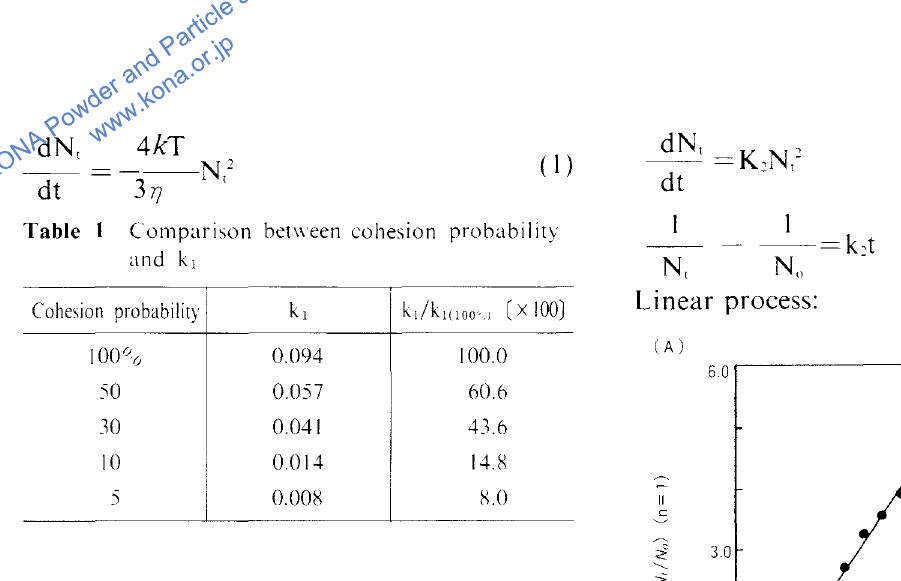
Comparison het\\ een cohesion prohahi I ity